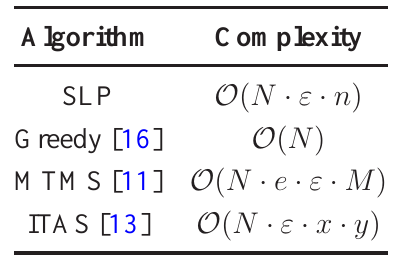
Table 1. Algorithm complexity